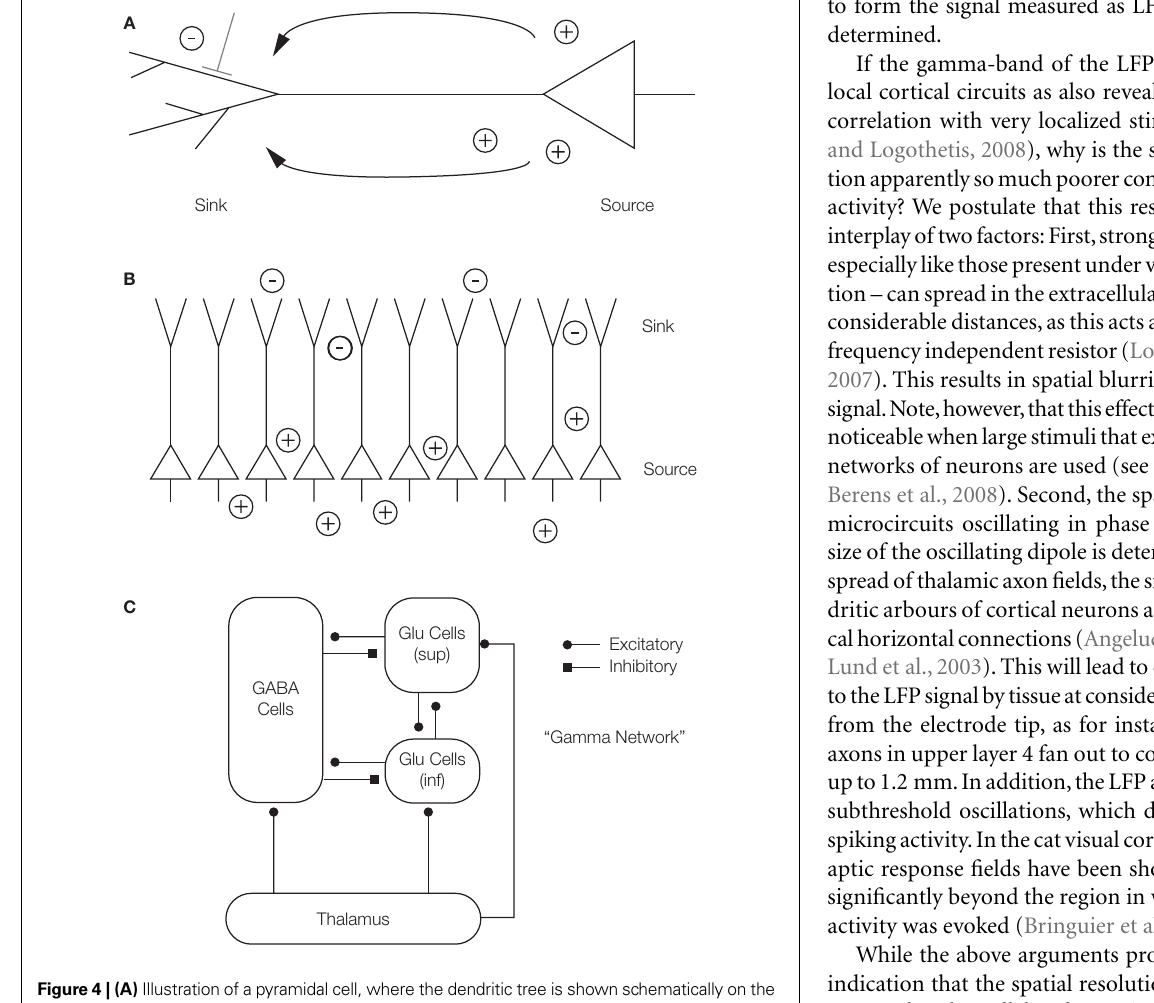
Figure 4 | (A) Illustration of a pyramidal cell, where the dendritic tree is shown schematically on the left, the cell body and axon on the right. A synaptic potential creates a current sink on the dendritic tree and a current-source at the soma. Adapted from Johnston and Wu (1995). (B) Pyramidal cells are aligned in a very stereotype fashion, with large dendritic arbours facing one direction and somata facing to the other. In this so-called open fi eld arrangement, synchronized synaptic input creates strong dipoles, since currents fl ow from individual cells do not cancel each other. (C) Illustration of the excitatory-inhibitory cortical network involved in the generation of gamma- oscillations. Thalamic inputs activate populations of infragranular (inf) and supragranular and granular (sup) glutamergic cells, as well as GABAergic cells. These three groups interact with each other. Inhibitory synapses are indicated by a square (symbol), excitatory synapses by a circle (symbol). Adapted from Logothetis